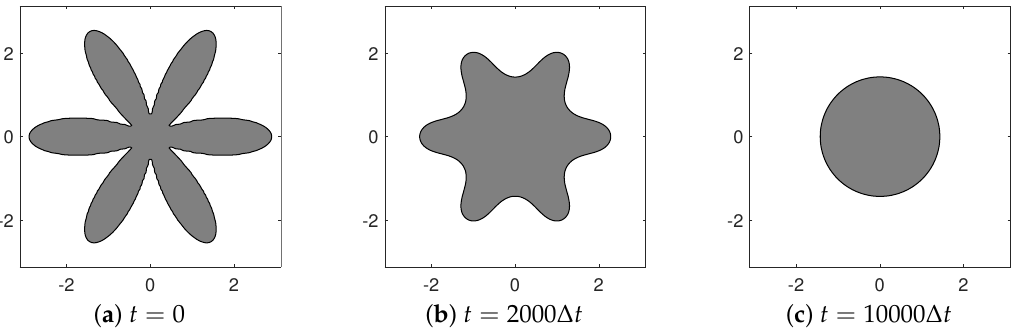
Figure 22. ( a – c ) are the zero-level contours over time with the AC equation (2) with the logarithmic Flory–Huggins free energy (55) and the initial condition (60) at t = 0, 2000 ∆ t , and 10000 ∆ t ,